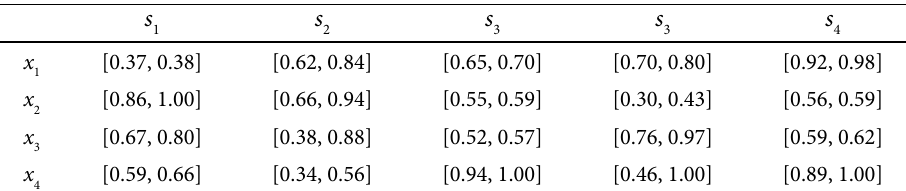
Table 10. Collective normalized uncertain decision matrix